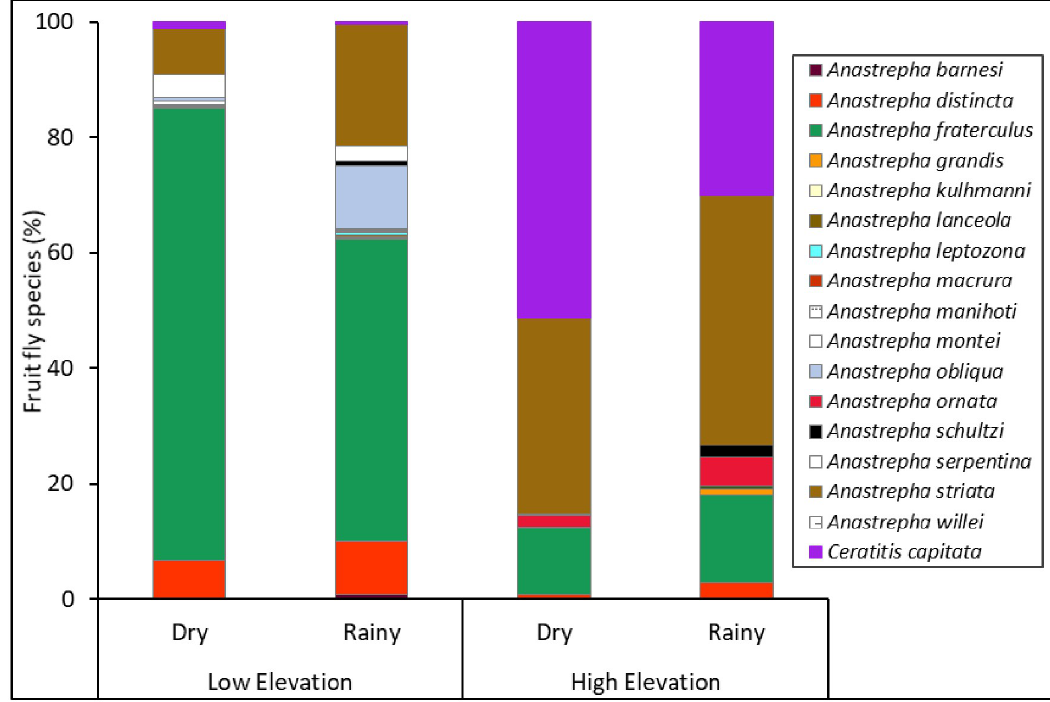
Fig 2. Fruit fly species composition in traps. Percent of fruit fly species captured in traps placed in guava orchards at different elevations (low and high) and seasons (dry and rainy) from 2013–2014.